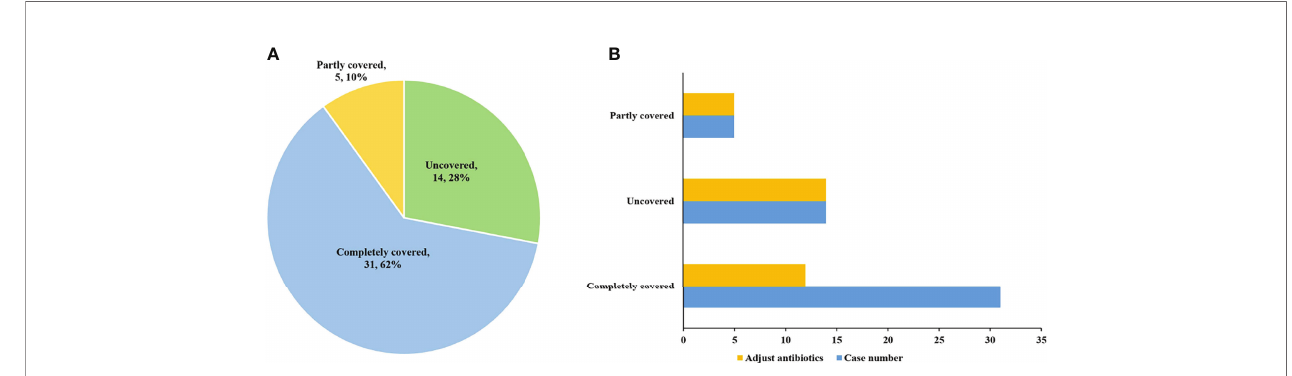
FIGURE 3 | The coverage and adjustment of antibiotics in the patients with pathogen positive pneumonia. (A) Among the patients with pathogen positive pneumonia, complete antibiotic coverage was 31 (62%); partial coverage was 5 (10%); and no coverage was 14 (28%). (B) Antibiotics were adjusted for 12 completely covered, and for all partly covered and uncovered